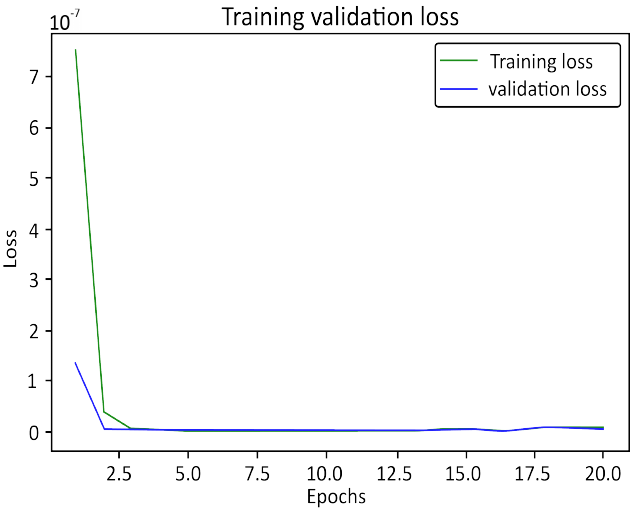
Figure 7. The Graph of training and validation losses with respect to twenty (20) number of epochs (Applying single train-validation-test split technique to DL model of Figure 3) in case of ReLU basic